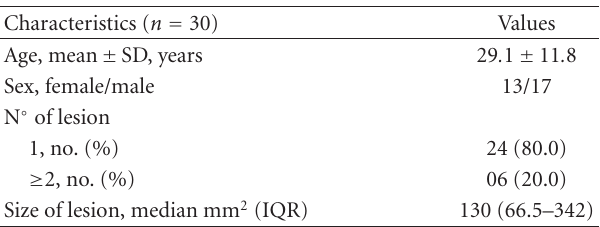
Table 1: Demographic characteristics of the cutaneous leishmania- sis patients included in the